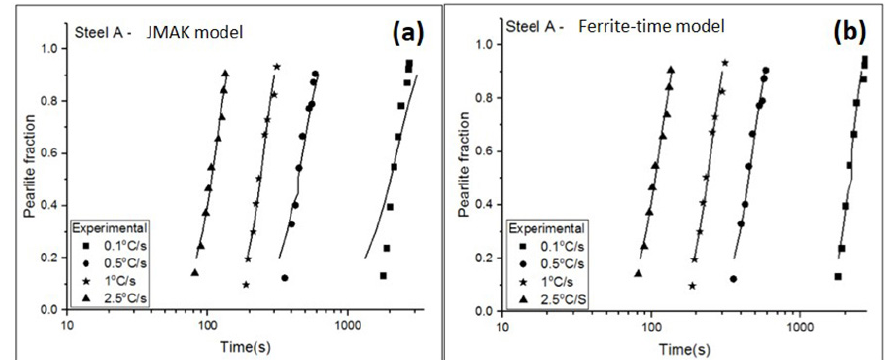
Figure 8. Pearlite fraction as a time function. (a) JMAK and (b) Ferrite-time equations fitted to the steel A experimental data.